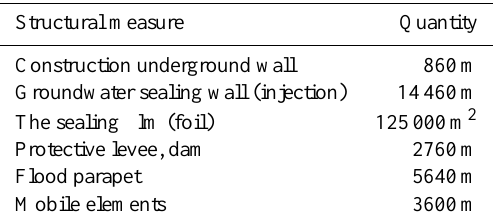
Table 3. Technical data of the flood protection measures taken in the city of Bratislava (Fig.